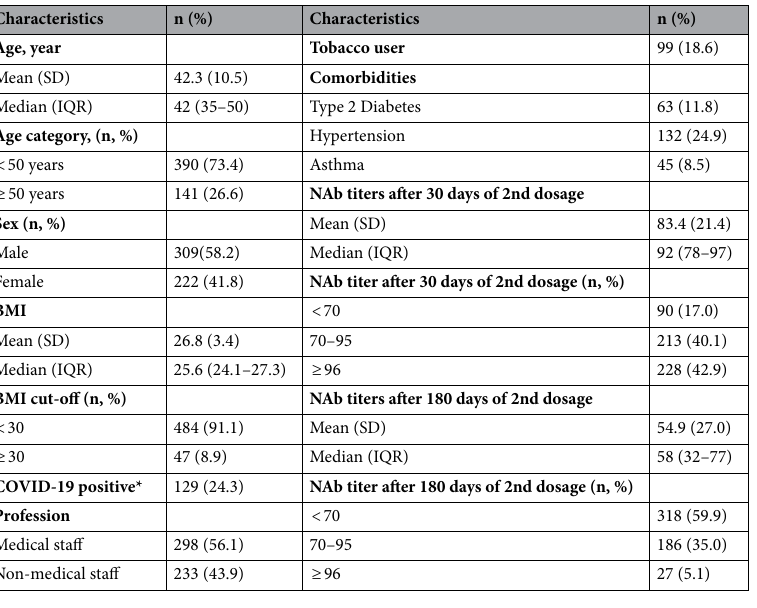
Table 1. Demographics and cohort characteristics of the study population (n = 531). SD standard deviation, IQR interquartile range, NAb neutralizing antibody. * Subjects who tested positive 30 days prior